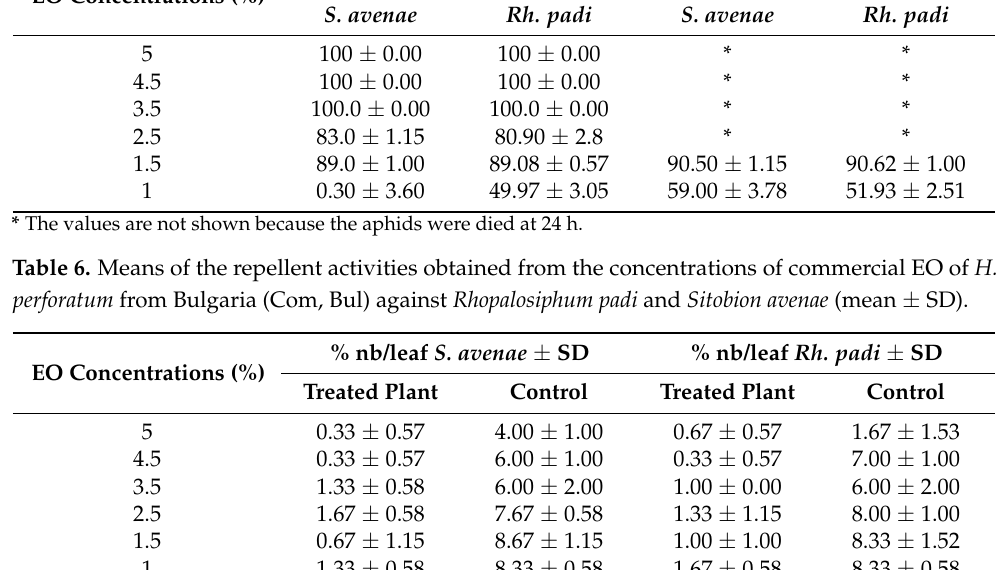
Table 5. The insecticidal effect of commercial EOs of H. perforatum from Bulgaria (Com, Bul) on two aphids (Rhopalosiphum padi and Sitobion avenae) (mean ± SD). After 24 h in % ± SD EO Concentrations (%)